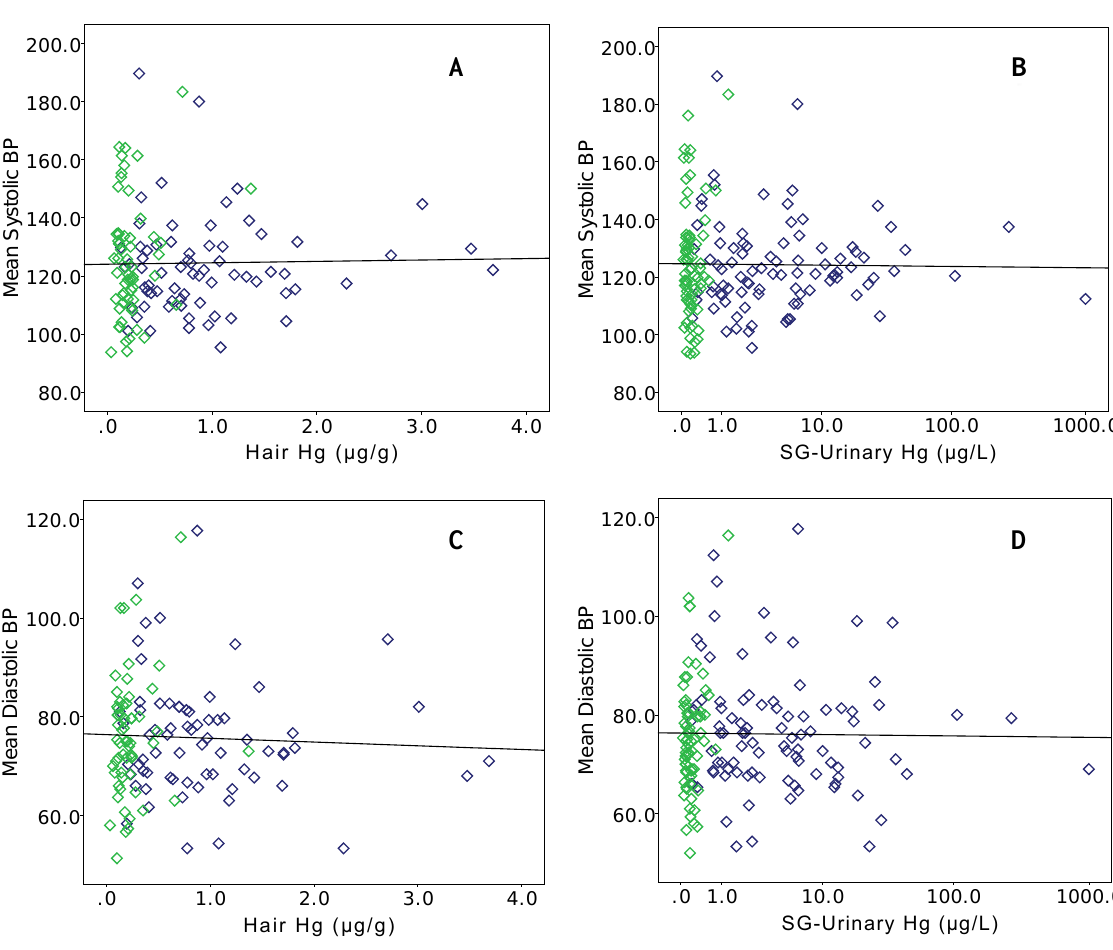
Figure 1. Scatterplots of BP by specific gravity-adjusted urinary Hg and hair Hg for Kejetia (dark blue) and Gorogo (green) participants. Systolic BP is represented at top with hair Hg ( A ) and SG-adjusted urinary Hg ( B ), and diastolic BP is displayed at bottom with hair Hg ( C ) and SG-adjusted urinary Hg ( D